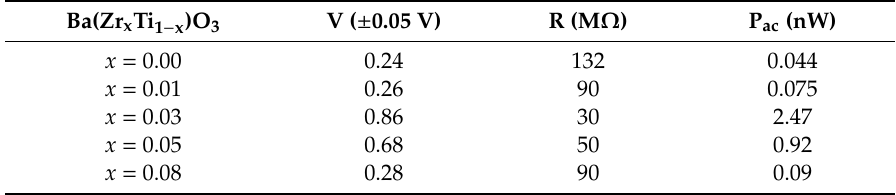
Table 2. Output power dissipated from the barium zirconate titanate (BZT)